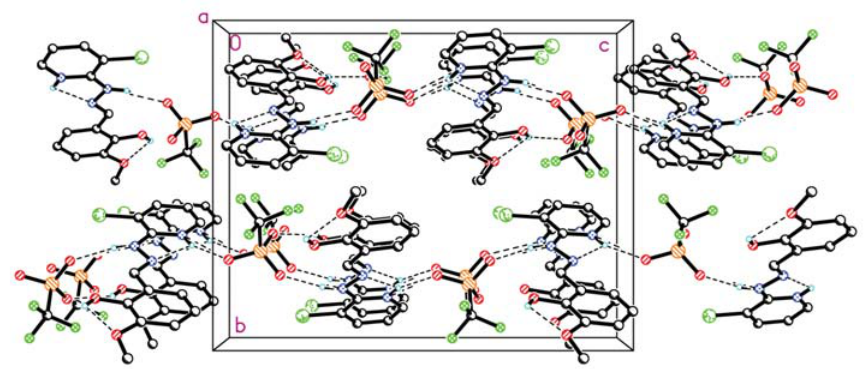
Figure 4. Packing diagram of 1 viewed along the a axis. Hydrogen bonds are shown as dashed